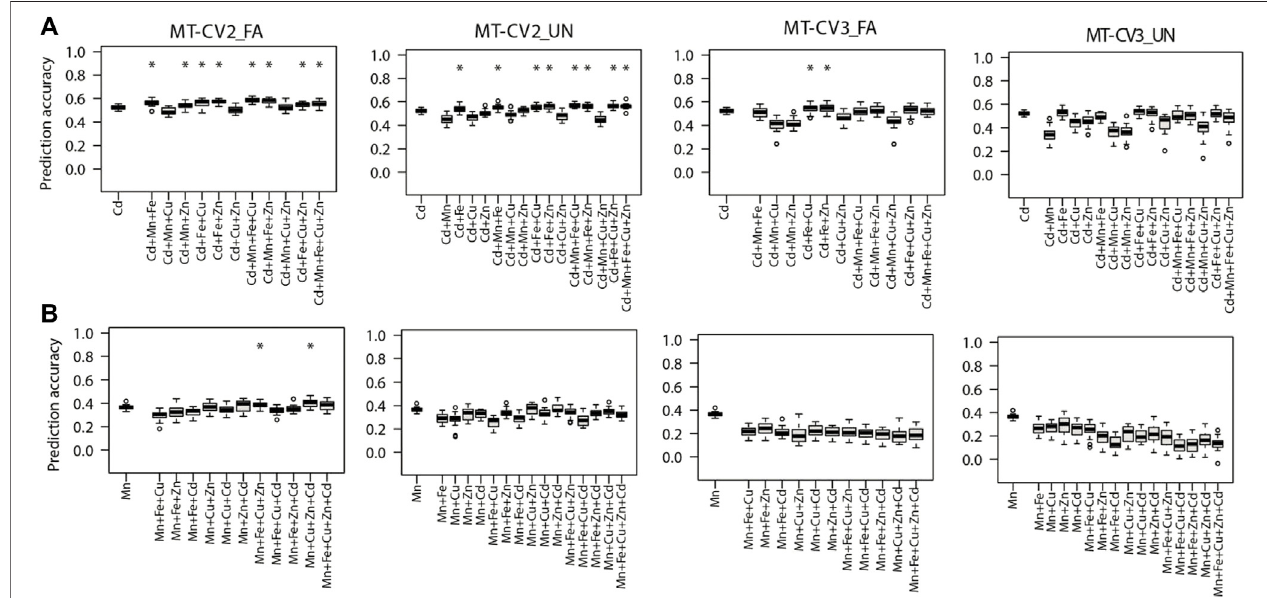
FIGURE 4 | Genomic prediction accuracies of the genotype-based single trait (ST) model (ST-GBLUP) and multi-trait (MT) models (MT-FA and MT-UN) under different cross-validation (CV) schemes (ST-CV1, MT-CV2, and MT-CV3). The target traits are (A) Cd and (B) Mn. The fi rst box-whisker in each portrayal indicates the accuracies of the ST-GBLUP model in the ST-CV1 scheme. Other box-whiskers refer to the accuracies achieved by MT models with different trait combinations. Asterisks above box-whiskers indicate that the prediction accuracies of the MT model for the speci fi c trait combination were statistically signi fi cantly ( p < 0.05, t -test) higher than those of the ST-GBLUP